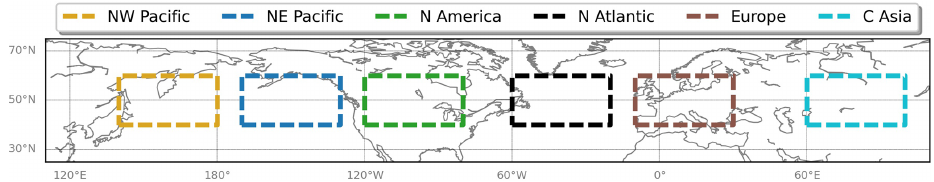
Figure 2. The rectangles outline six regions in the Northern Hemisphere midlatitudes where dedicated analyses are performed in parts of this study. The six regions extend from 40 to 60 ◦ N in latitude and are restricted to the 140 ◦ E–180 ◦ , 170–130 ◦ W, 120–80 ◦ W, 60–20 ◦ W, 10 ◦ W–30 ◦ E, and 60–100 ◦ E longitudinal ranges for the NW Pacific (yellow), NE Pacific (blue), N America (green), N Atlantic (black), Europe (brown), and central Asia (cyan), respectively.